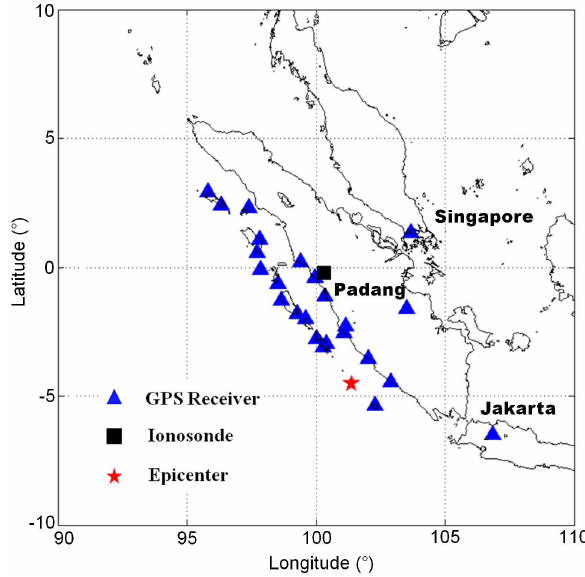
Fig. 4. Map of the epicenter of the 2007 Southern Sumatra earth- quake, GPS ground receivers, and Kototabang ionosonde